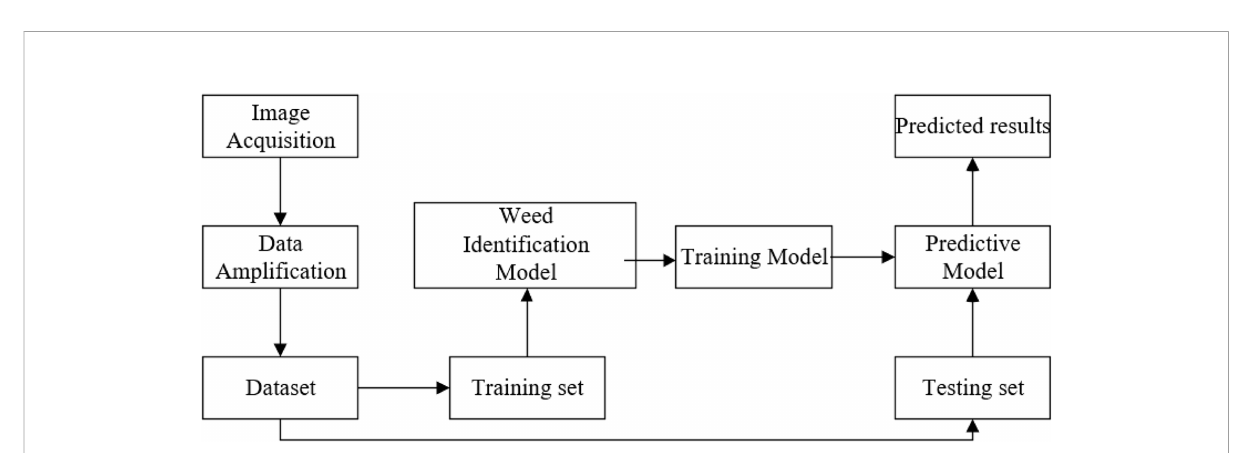
FIGURE 1 The weed identi fi cation